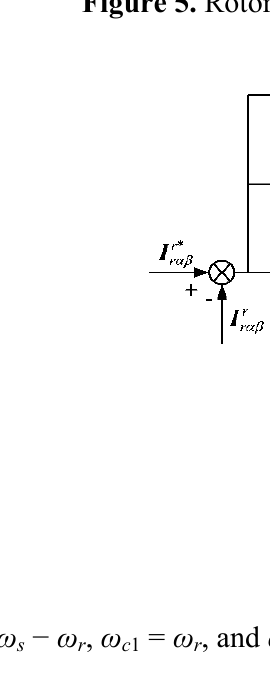
Figure 5. Rotor current control scheme based on PR